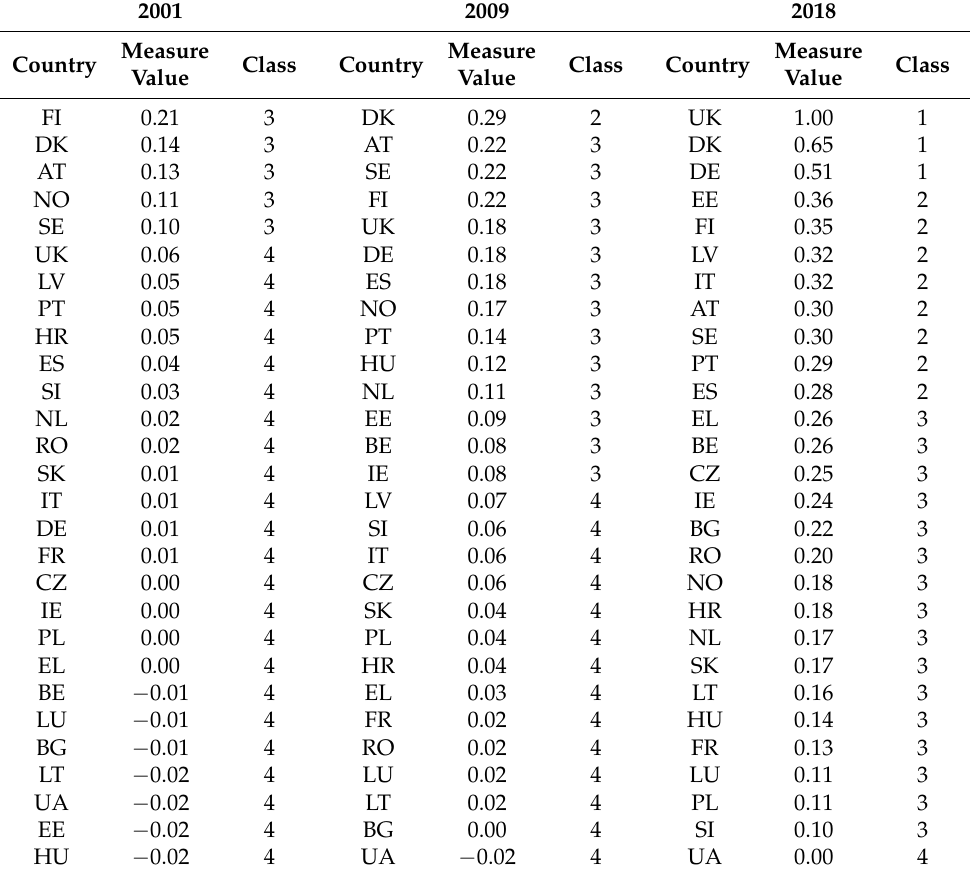
Table 6. Ranking of selected European countries in 2001, 2009 and 2018 (VMCM) with respect to the United Kingdom (UK) pattern and Ukraine (UA) anti-pattern—base year